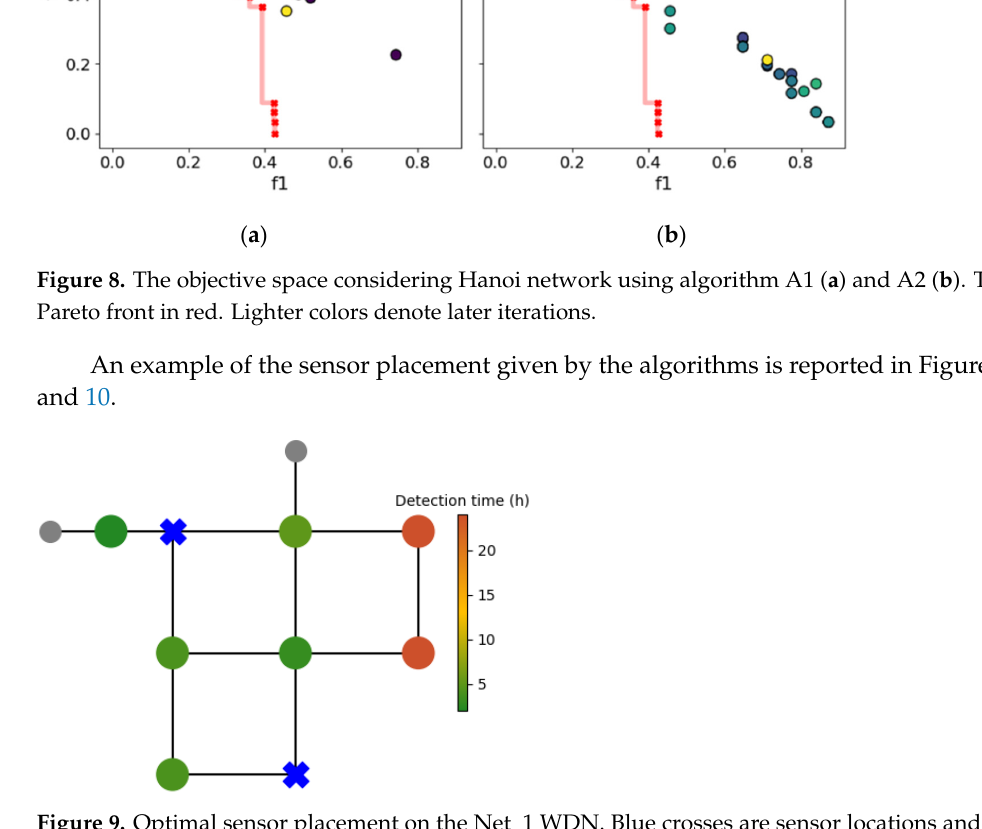
Figure 9. Optimal sensor placement on the Net_1 WDN. Blue crosses are sensor locations and the colors denote the detection time. Grey nodes are a reservoir (left) and a tank (top), which are not considered possible sensor locations.